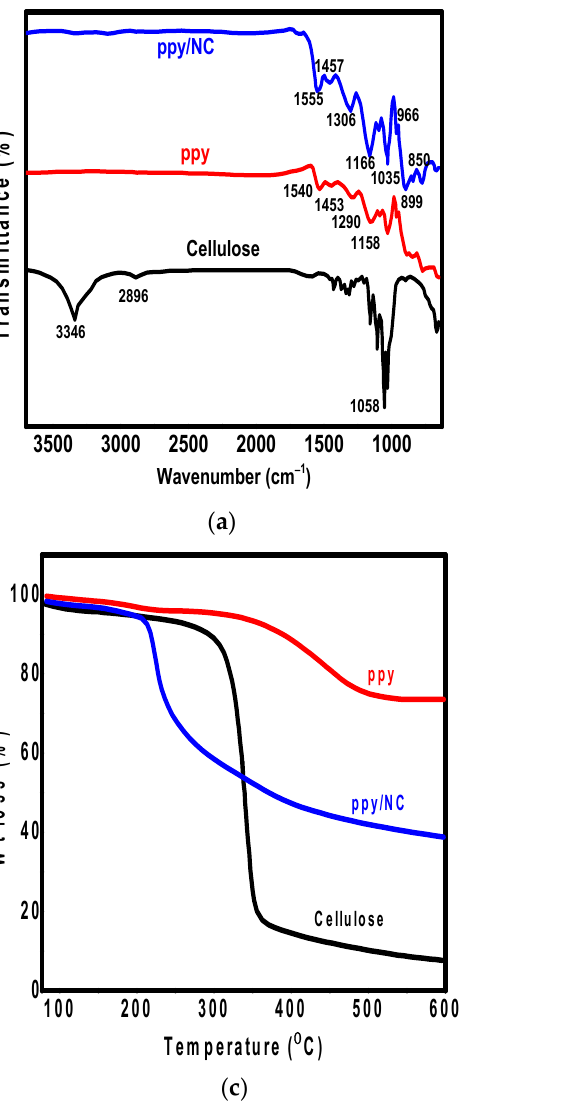
Figure 1. FT-IR ( a ) XRD ( b ), TGA ( c ), and zeta potential at various pH ( d ) of the synthesized ppy, cellulose, and ppy/NC nanocomposite